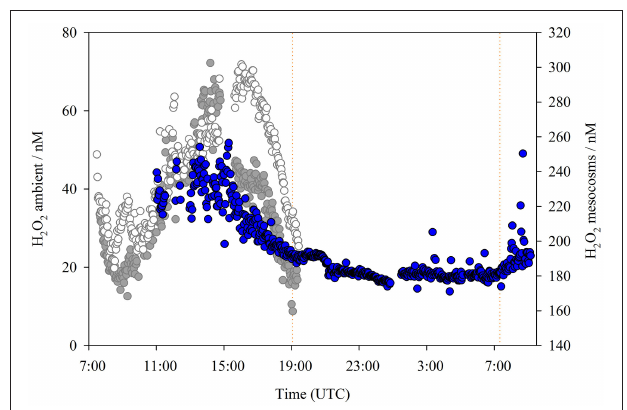
FIGURE 2 | H 2 O 2 concentrations (nM) in ambient waters adjacent to the mesocosm sampling jetty over a complete diurnal cycle at ∼ 2min resolution (blue circles), superimposed on H 2 O 2 concentrations for different days (as per Figure 3 ) from within the 1,450 µ atm pCO 2 (dark gray) and 400 µ atm pCO 2 (light gray) mesocosms Ambient H 2 O 2 concentration data collected 5–6 March 2016. All times are UTC, sunrise/sunset (illustrated) refers to Las Palmas: sunrise (5 March) 7:21, sunset (5 March) 19:04, sunrise (6 March) 07:20. The sample line was positioned at ∼ 10cm depth. There was no large change in surface salinity over the experiment duration (range 0.2 practical salinity